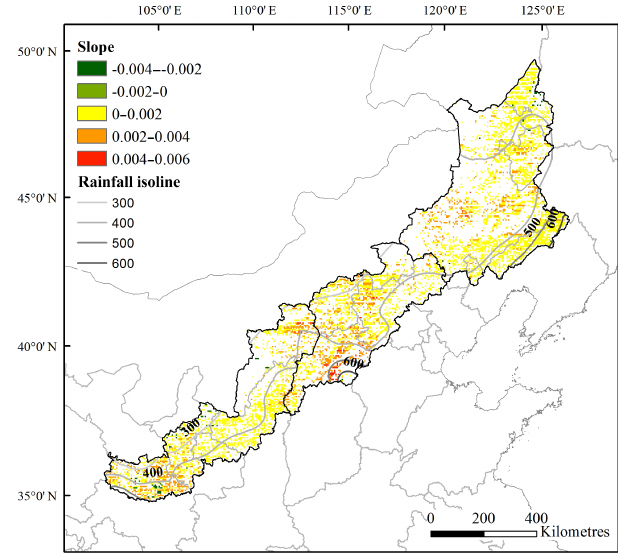
Figure 11. Slope of the linear regression of spring maize yield loss ratio from 1966 to